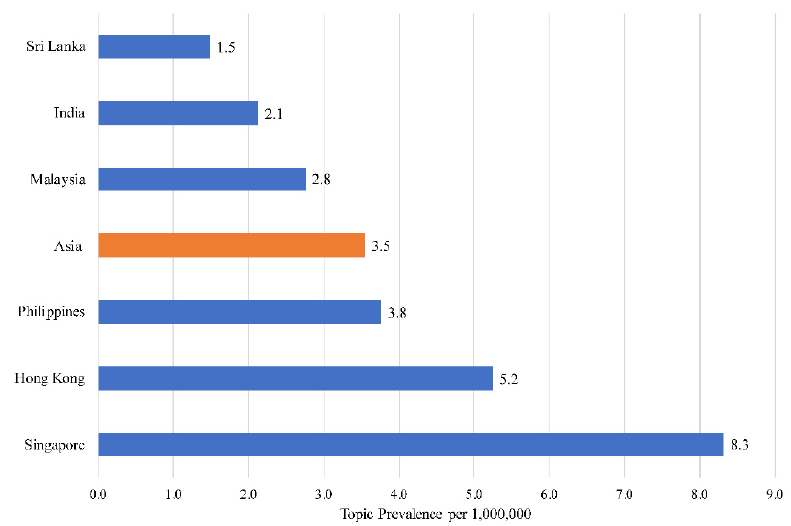
Figure 1. Prevalence of societal narratives on caregivers across six Asian countries/cities. Table 1. Topics and associated keywords of societal narratives on caregivers across six Asian countries/cities. Country Topic Collocates (Keywords) Specialized and institu- Sri Lanka